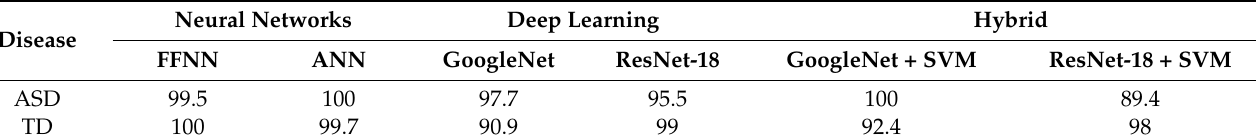
Table 9. Accuracy reached by proposed system in the diagnosis of each class.